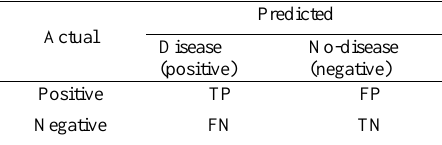
Figure 1. Confusion matrix in this work.